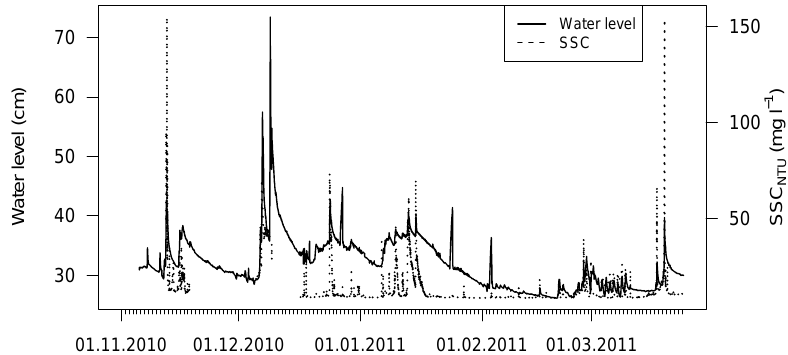
Fig. 4. Example of the temporal variation of the suspended sediment concentration (SSC) and water level (Site A, Season 1).